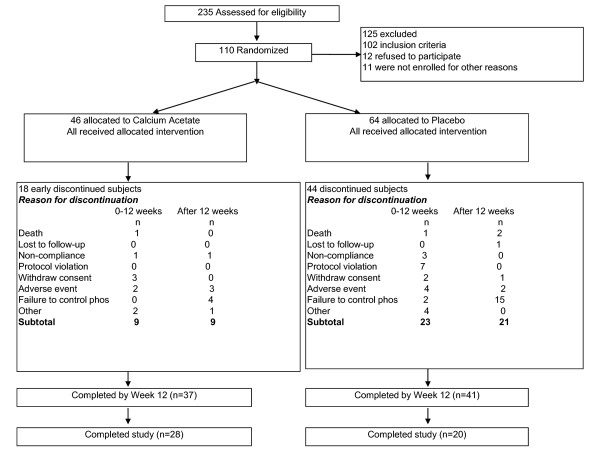
Patient disposition from screening to end of study.